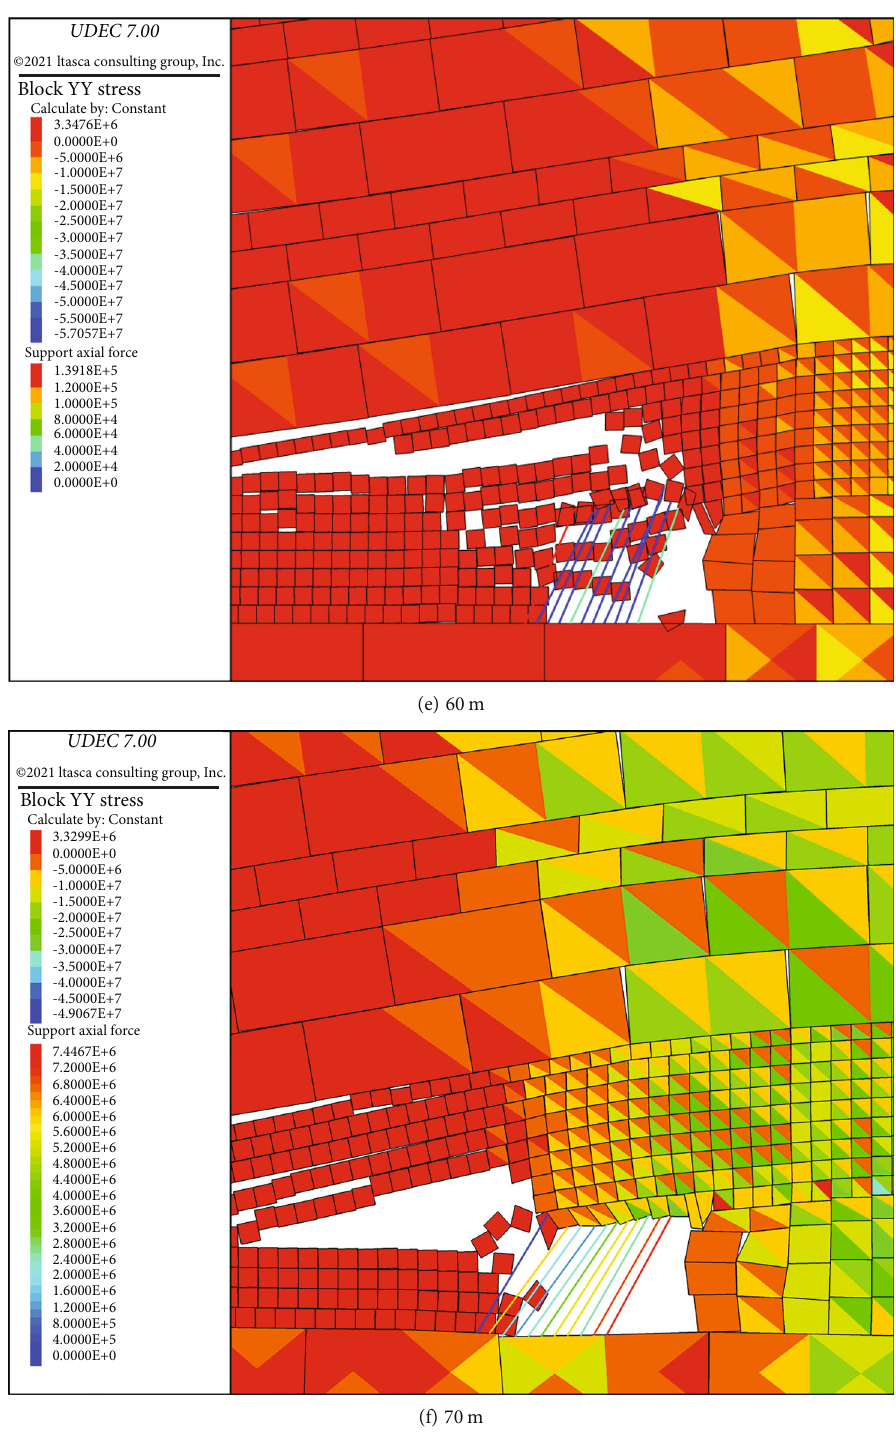
Figure 18: Stability of end face roof under di ff erent advancing